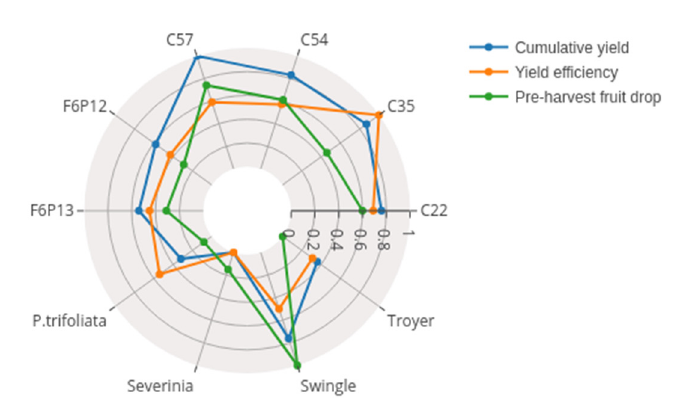
Figure 8. Radar chart showing the yield performance of the 10 rootstocks in combination with Mandared. Data were rescaled independently, normalizing the best performance to 1 and the worst performance to 0 for each parameter.